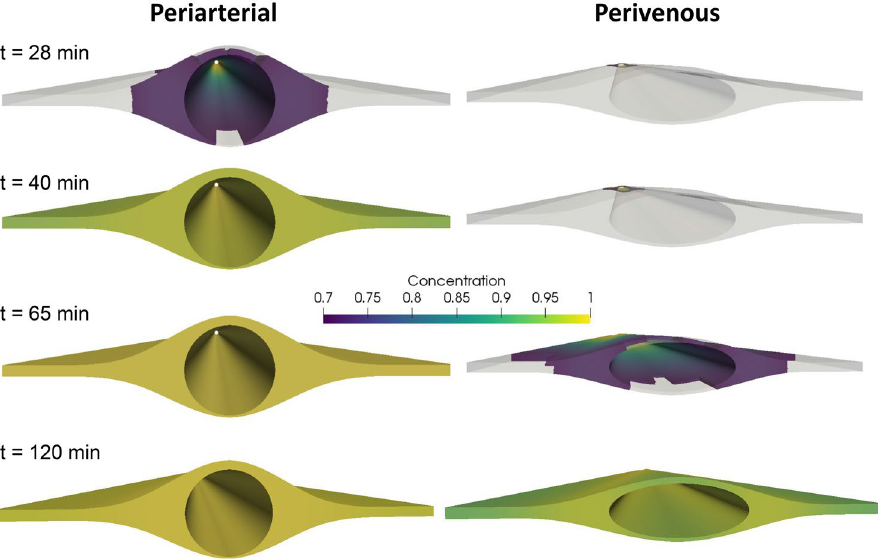
Figure 7. Tracer (2000 kDa) distribution around the artery (left) and the vein (right) at several time points after injection in the idealized geometries. The front end shows the site of measurement, while the point of injection is in the far end of the geometry. Colors indicate a threshold of 0.7. At 28 min after injection, the areas of intense concentration around the artery suggest two disjoint PVS. After 40 min, the concentration is almost uniform at the cross section at the artery PVS, while no tracer is found around the vein. At 65 min after injection, tracer appears around the vein, apparently forming two disjoint PVS. After 120 min, tracer is distributed almost uniformly over both cross